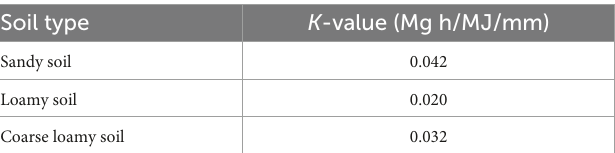
TABLE 2 K -values for different soil types (after Jain et al., 2010).